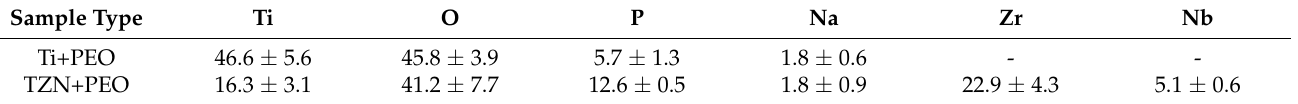
Table 2. Elemental composition (wt %) of the PEO coatings from the energy-dispersive X-ray spectroscopy (EDX) analysis. Sample Type